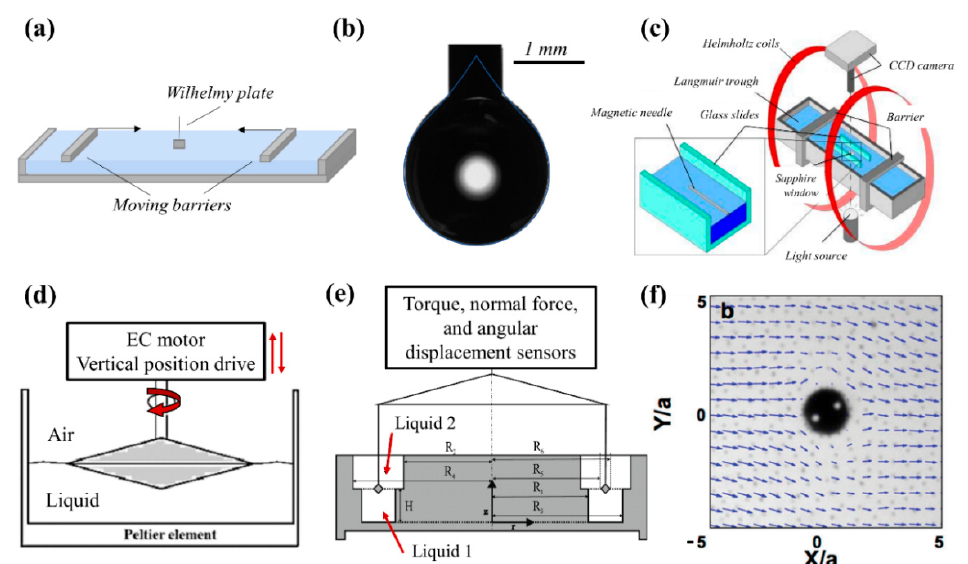
Figure 5. (Color online) Examples of techniques used to perform interfacial rheological measurements. ( a ) Langmuir Trough—measures the pressure at the interface in response to applied compression and expansion; ( b ) Pendant Drop—fits the shape of a droplet hanging from a needle in response to expansion and contraction of its volume; ( c ) Magnetic Needle—measurements of interfacial rheology by shearing the interface with a needle-like probe using an externally applied magnetic field; ( d ) Bicone—shearing of the interface with a conical shaped probe; ( e ) Double-walled Ring geometry (R 1 -R 4 define the dimensions of the cup, R 5 and R 6 indicate the ring dimensions, and H is the distance from the interface to the bottom of the circular channel) —shearing of the interface with a ring; ( f ) Microrheology—indirect measurements of rheological properties utilizing a microparticle probe pinned at the fluid interface. The radius of the micro-probe, a, is 50 µ m in this figure. Panel ( c ) reprinted with permission from [202], copyright 2021 American Chemical Society. Panel ( d ) reprinted from the open access [184]. Panel ( e ) reprinted by permission from [Springer Nature]: [MDPI AG] [Rheologica Acta] [204] [Copyright 2021]. Panel ( f ) reprinted with permission from [206], copyright 2021, The Society of Rheology.